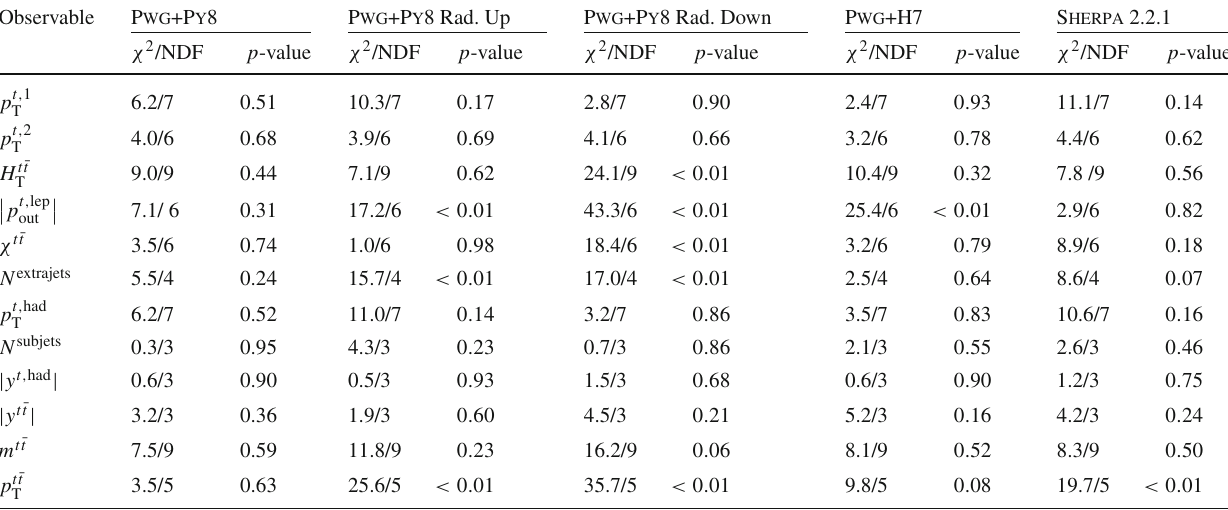
Table 13 Comparison of the measured particle-level normalised single-differential cross-sections in the boosted topology with the pre- dictions from several MC generators. For each prediction a χ 2 and a